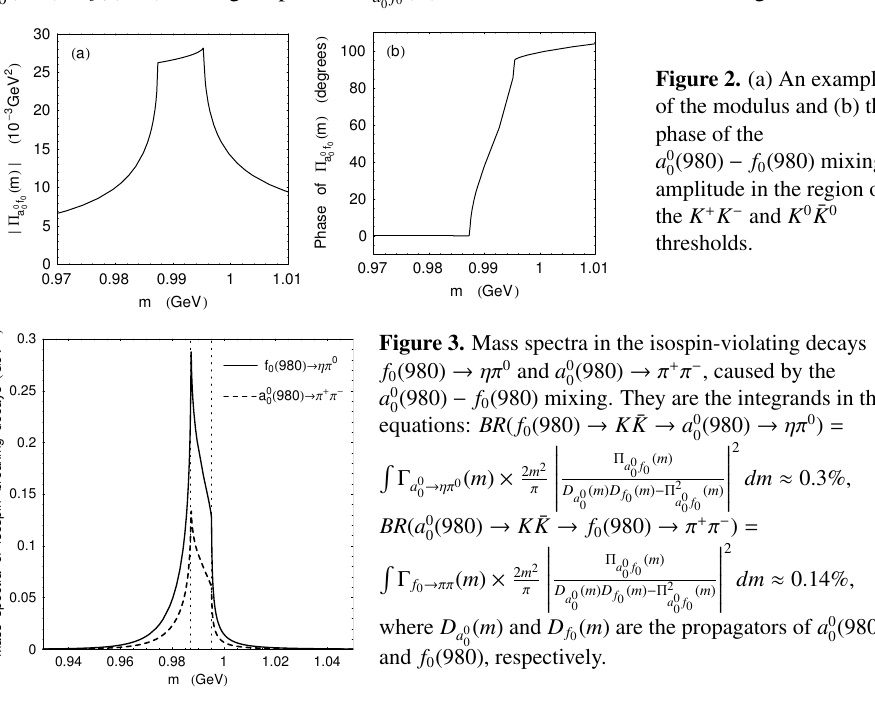
where D ( m ) and D f a 0 0 and f 0 (980),